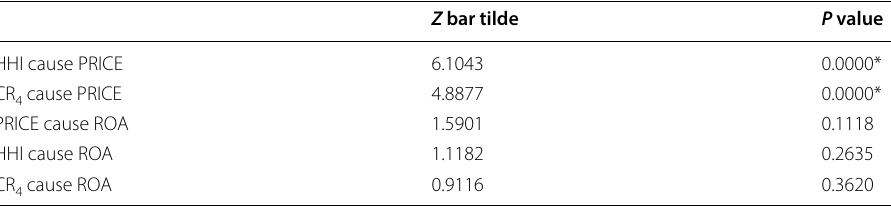
Table 3 Granger causality test for SCP hypothesis. Source: Author’s calculation on data provided by the Indonesia Financial Services